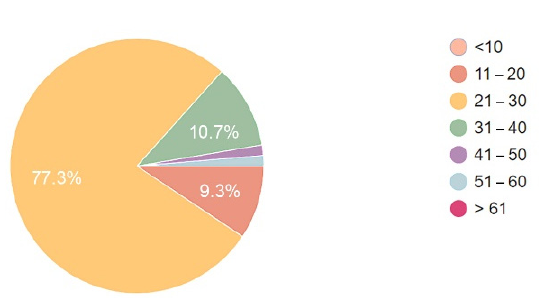
Figure 9. Age of respondent patients.